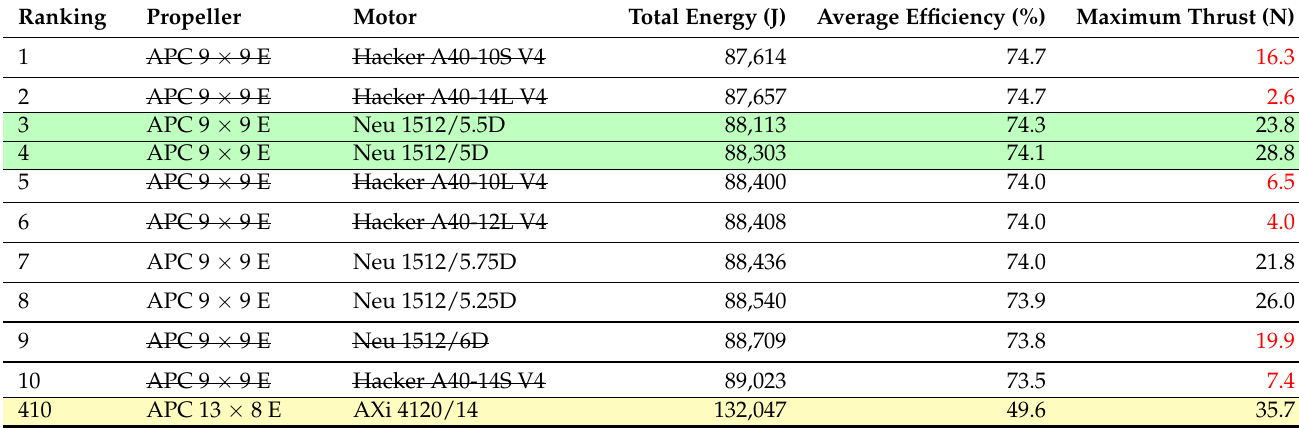
Table 1. The propulsion system optimization results sorted by efficiency for the simulated 1 km by 1 km field coverage mission; note that combinations with insufficient thrust at minimum speed are crossed out (struck through), the most efficient combinations with sufficient thrust at minimum speed are highlighted in green, and the baseline combination is highlighted in